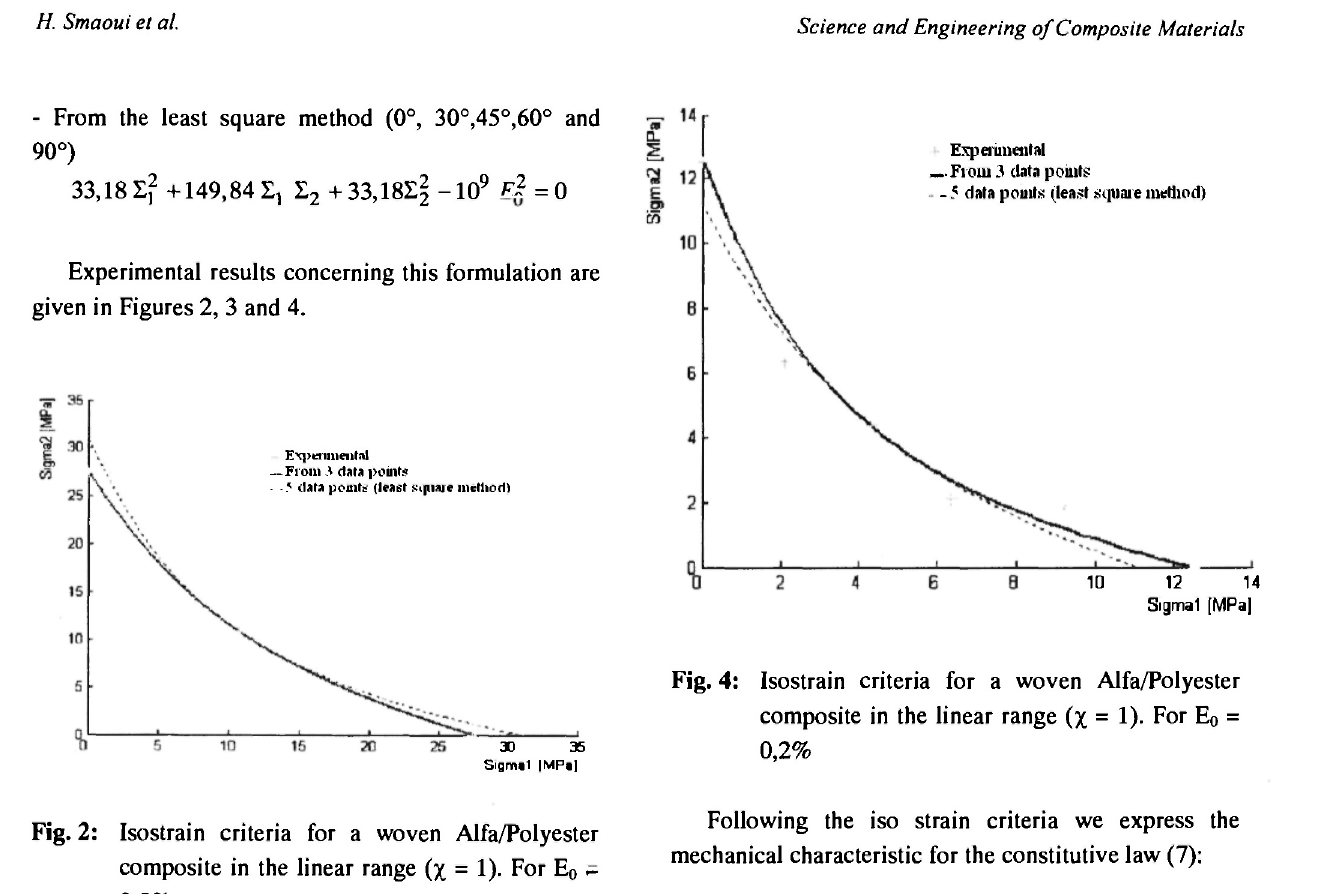
Fig. 2: Isostrain criteria for a woven Alfa/Polyester composite in the linear range (χ = 1). For E 0 - 0,5%